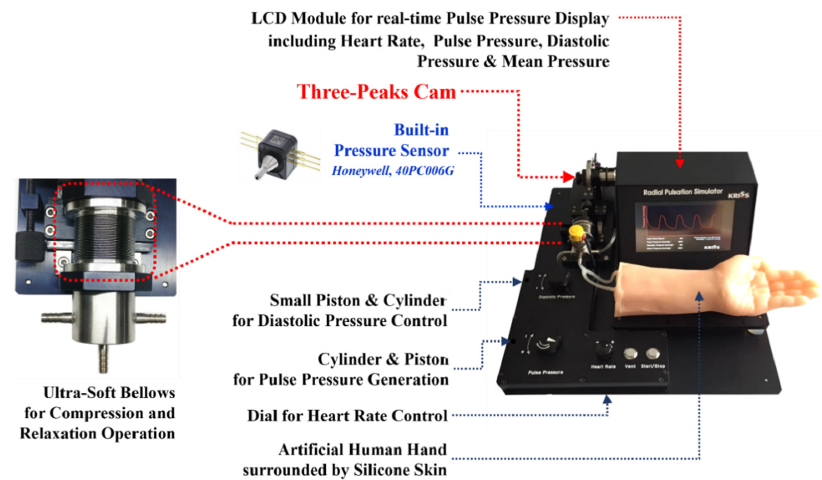
Figure 1. Developed three-peak cam-based radial pulsation simulator for generating age-dependent radial pulse waveforms.